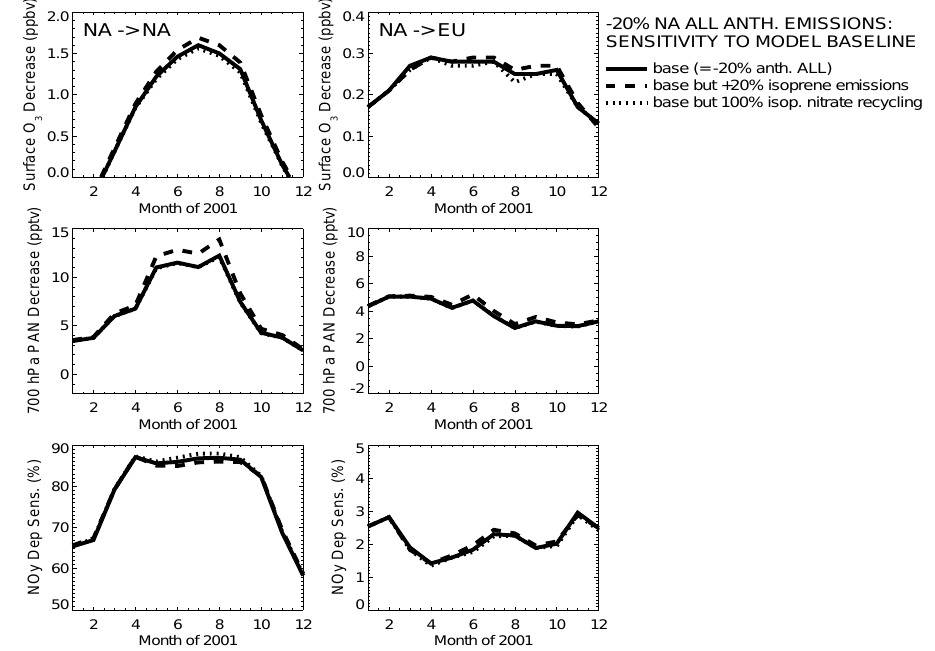
Fig. 7. The monthly mean regional (left) and intercontinental (right) 1 O 3 ANTH in surface air (top), 1 PAN ANTH at 700hPa (middle), and NO y deposition sensitivity (bottom) with different model baselines: as in Fig. 4 (solid; SR1-SR6NA), with NA isoprene emissions increased by 20% (dashed; ISOPNA-SR6ISOPNA), and with the isoprene nitrate recycling rate increased from 40% (as in SR1) to 100% (dotted; SR1 r100-SR6NA r100). NO y deposition sensitivity is defined as the regional change in NO y deposition divided by the change in NA NO x emissions (Sanderson et al.,